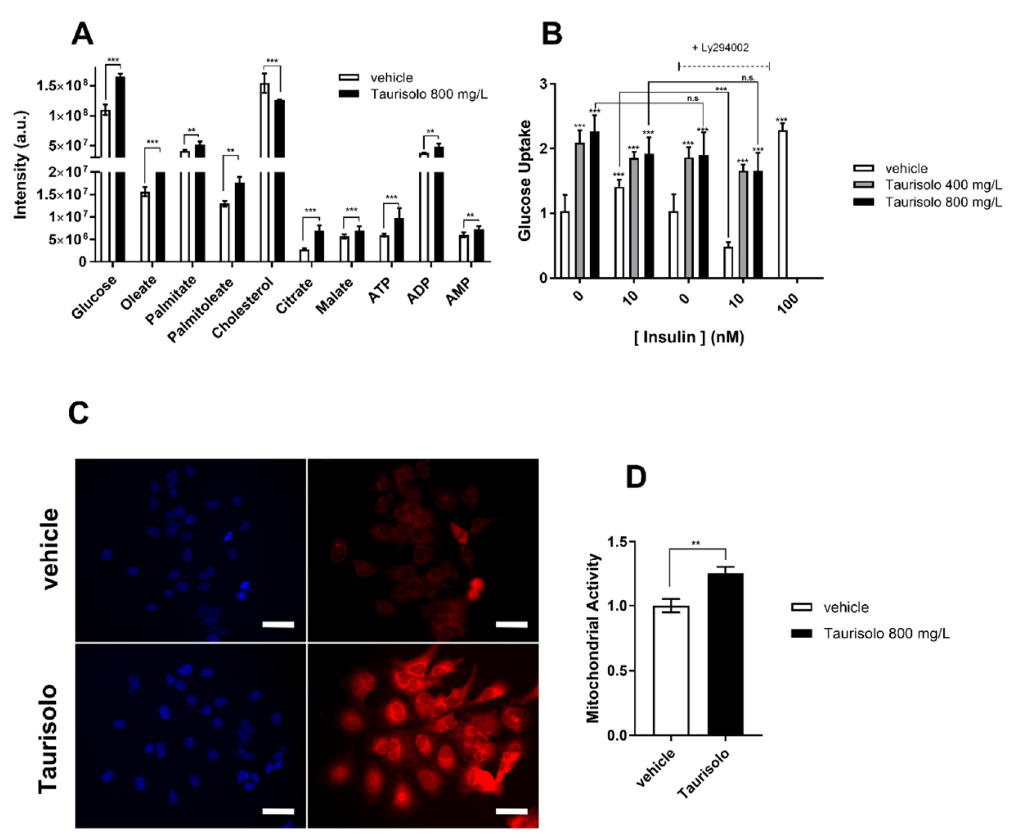
Figure 1. Taurisolo shifts HuH7 metabolism toward mitochondrial respiration. ( A ) Metabolomic profiling of HuH7 cells grown for 72 h in the presence of Taurisolo (800 mg / L) (black bars) or of vehicle (white bars) (see also Table 1). Each bar represents the mass spectrometry intensity of the indicated metabolites as measured by FT-ICR-MS. ( B ) Glucose uptake of HuH7 cells grown for 72 h in the presence of 400 mg / L (gray bars), 800 mg / L (black bars) Taurisolo, or of vehicle (white bars). When indicated 10 nM insulin and / or 10 µ M LY294002 was added to the cell. ( C , D ) Fluorescent emission of MitoTracker CMX-ROS (red channel) visualized by fluorescence microscopy ( C ) or by spectrofluorimetric measurement ( D ) in HuH7 cells growing for 72 h in the presence of Taurisolo (800 mg / L) or of vehicle. Cell nuclei were counterstained with DAPI (blue channel). In D MitoTracker emission was normalized with DAPI to account for the cell number. Each bar represents normalized intensity of Mitotracker in HuH7 treated with 800 mg / L (black bars) Taurisolo, or with vehicle (white bars). In C scale bars correspond to 14 µ m. (In ( A , B , D ) data are representative of n = 3 measurements, shown is mean ± s.e.m. Two-way ANOVA and Bonferroni post-test analysis were performed; *** = p < 0.001; ** = p < 0.01; n.s. = non-statistically different).